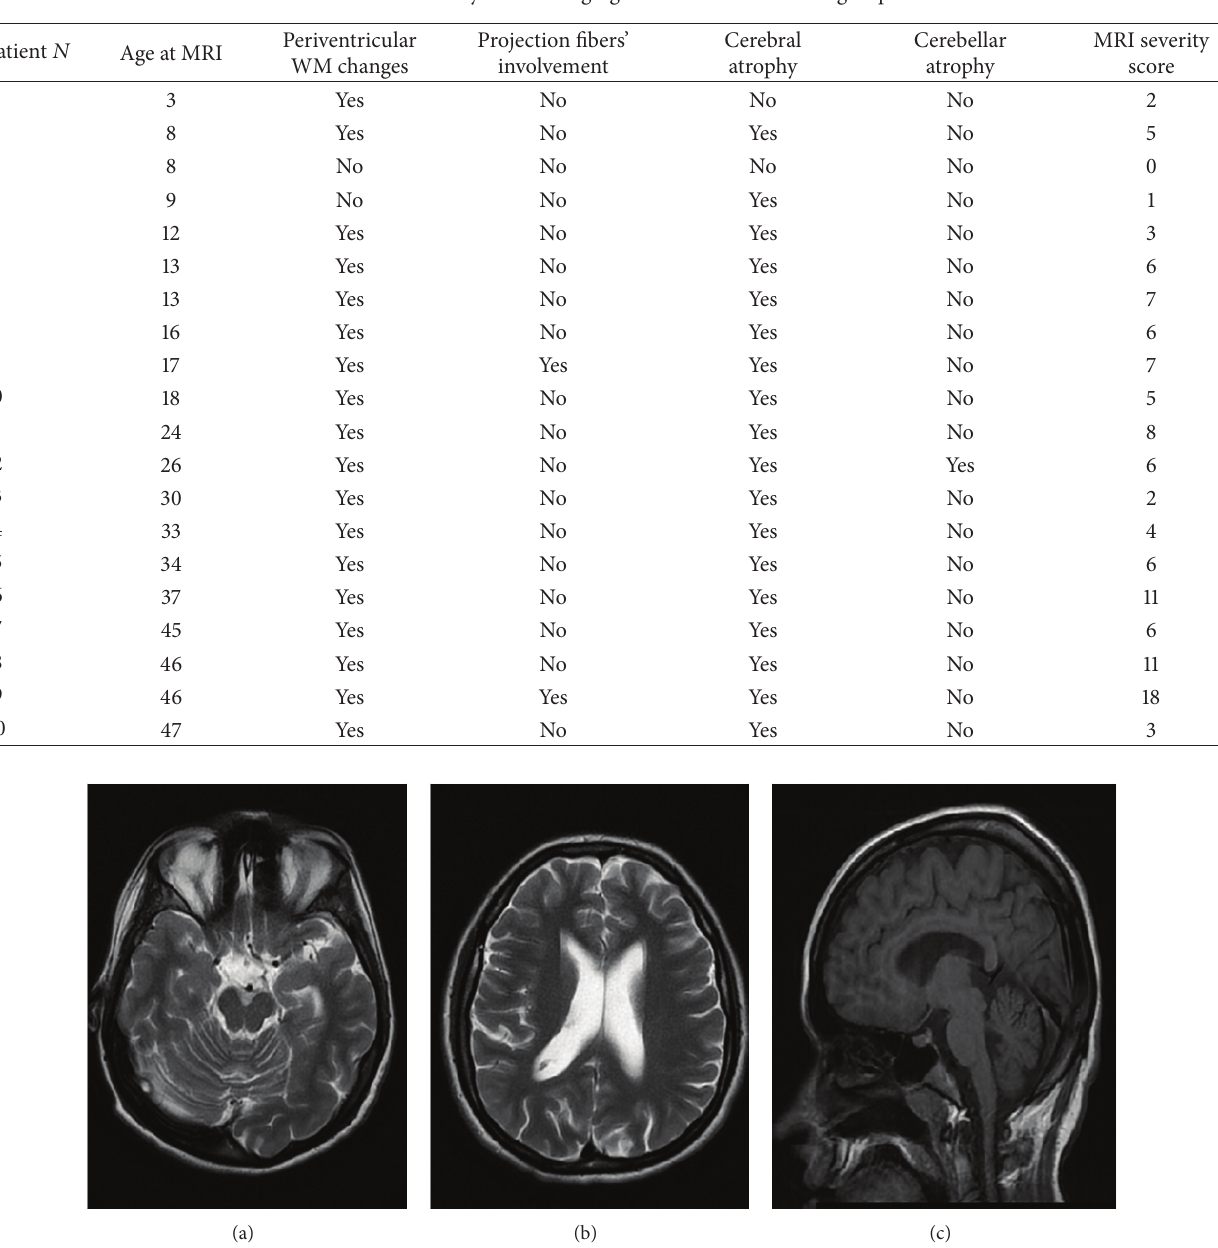
Figure 1: Patient number 12: a 26-year-old woman with cerebral and cerebellar atrophy and severity score 6. (a), (b) Axial T2W images show global cerebral atrophy with dilatation of subarachnoid spaces and ventricular system. Dilatation of interfoliar cistern as a consequence of cerebellar atrophy. (c) Sagittal T1W image demonstrates widening of subarachnoid spaces supratentorial and